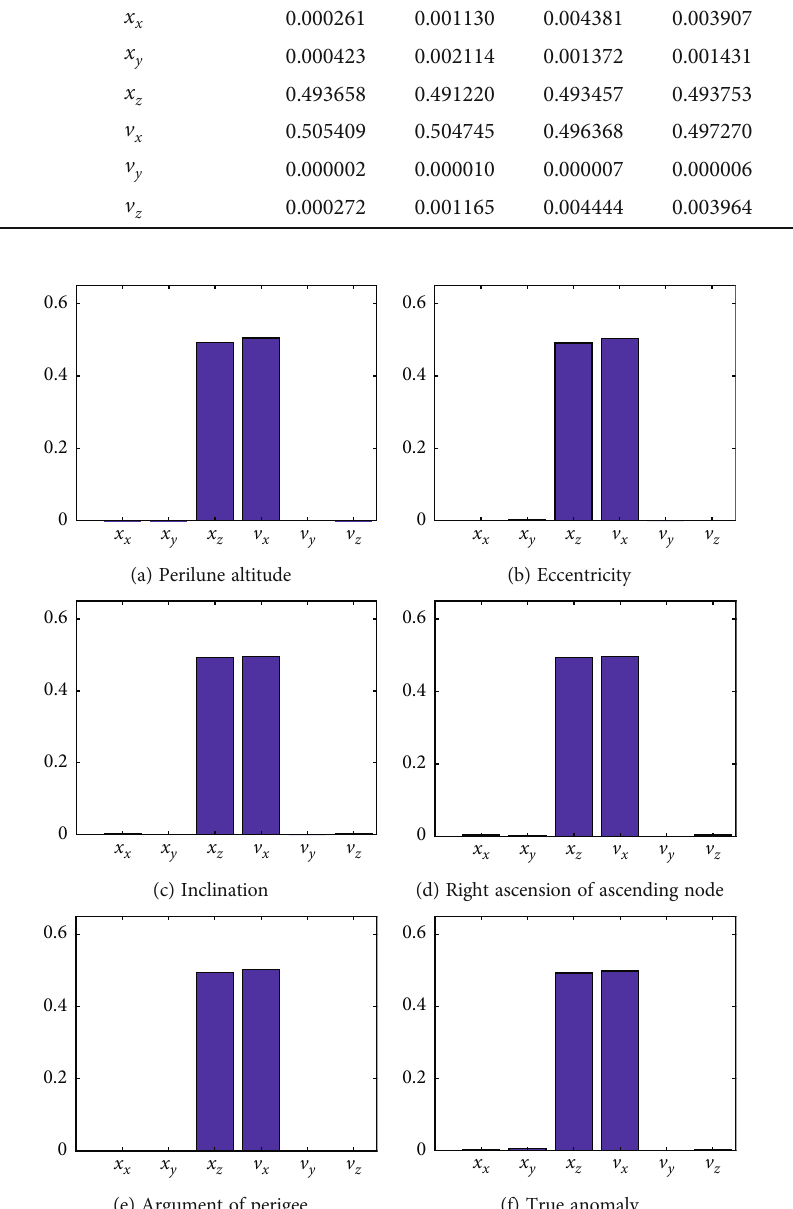
Figure 10: Histogram of the global sensitivity index of the position and velocity parameters to the orbital elements at the